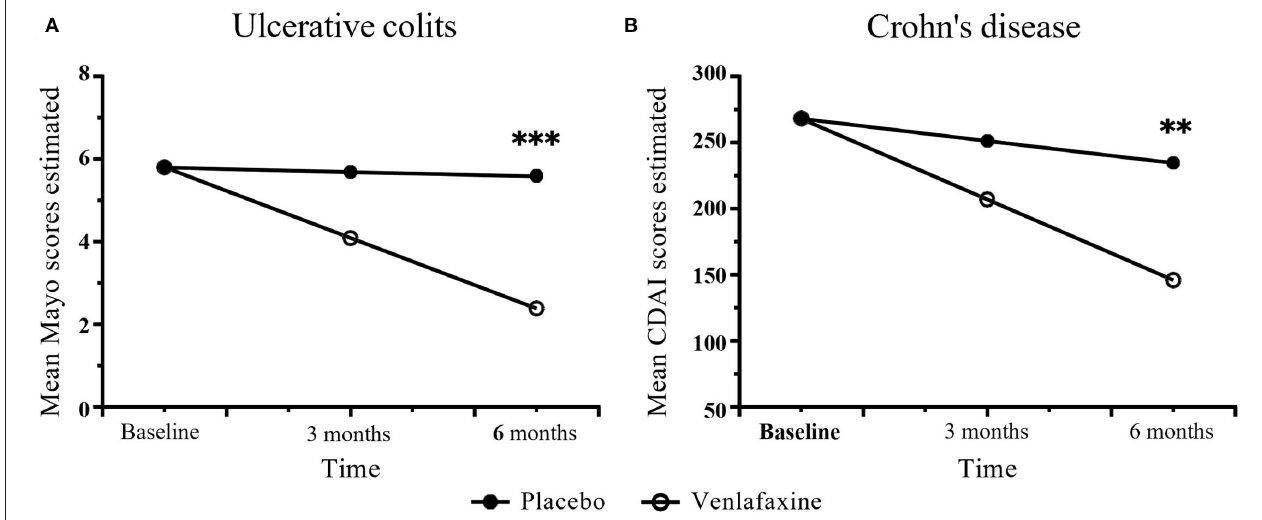
FIGURE 3 | Disease activity measured with Mayo score in UC (A) and Crohn’s Disease Activity Index (CDAI) score in CD (B) during the study period in venlafaxine group and placebo group. Effect size between the venlafaxine group and placebo group is significant with ** p < 0.01 and *** p <